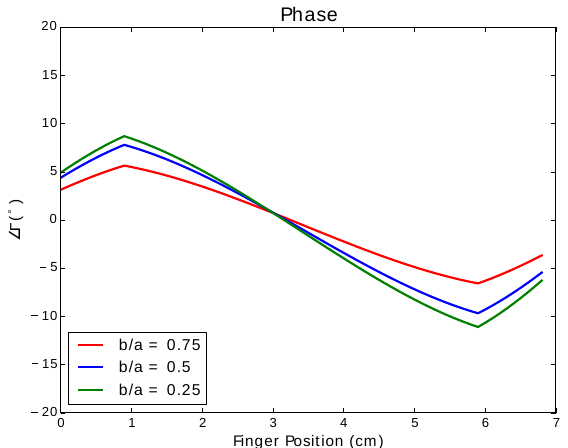
Figure 12. Phase of the reflection coefficient of a simulated quarterwave short-circuit stub using a coax.